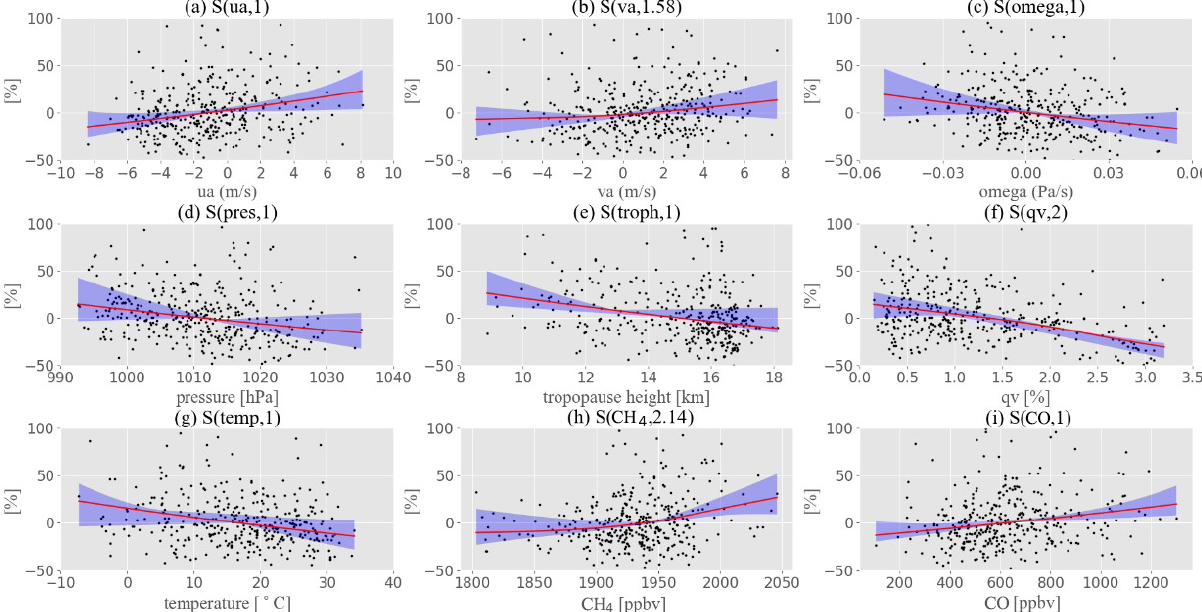
Figure 5. The influence of each individual variable in the GAMs model on C 2 H 6 troDMF from 2015 to 2020 over Hefei, eastern China. Panels (a)–(i) are for zonal wind (ua), meridional wind (va), convection wind (omega), pressure (pres), tropopause height (troph), H 2 O troDMF (qv), temperature (temp), CH 4 troDMF (CH 4 ), and CO troDMF (co), respectively. The DOFS of each smoothing function is included in the parenthetical information in each panel heading. The x axis represents the variation range of each variable, and the y axis represents the relative percentage change in C 2 H 6 troDMF relative to its annual mean